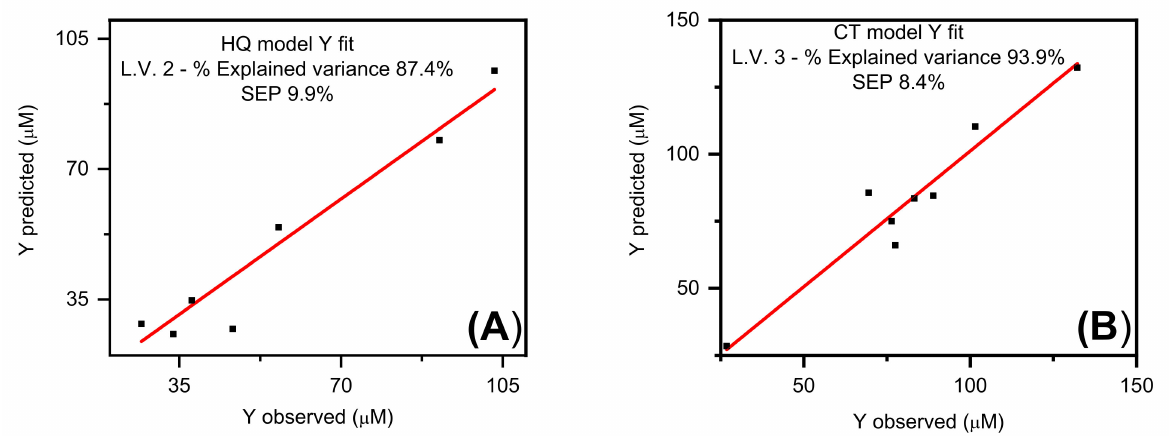
Figure 6. Plot of ( A ) HQ and ( B ) CT predicted concentrations as a function of the nominal values in validation samples for determination in wine industry wastewater by PLS calibration